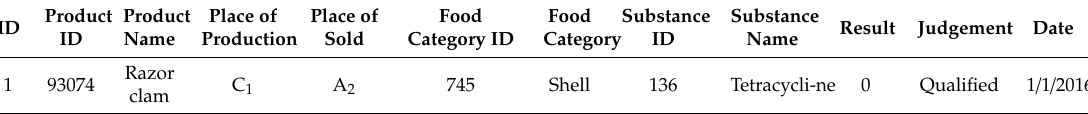
Table 1. An example of the dataset.